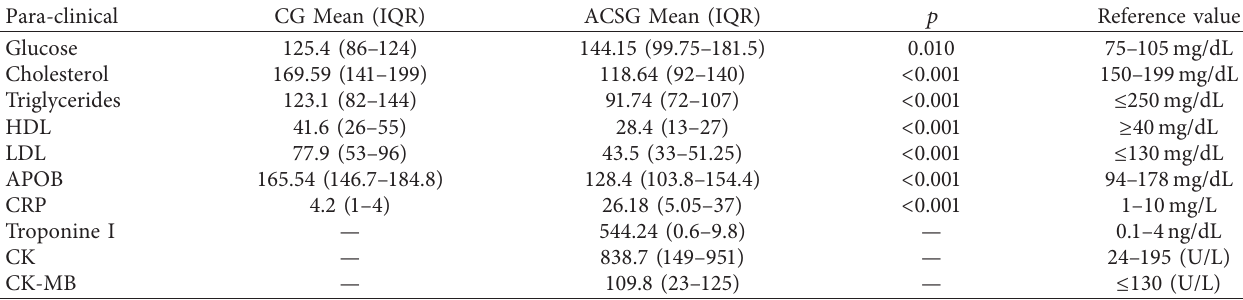
Table 2: Biochemical